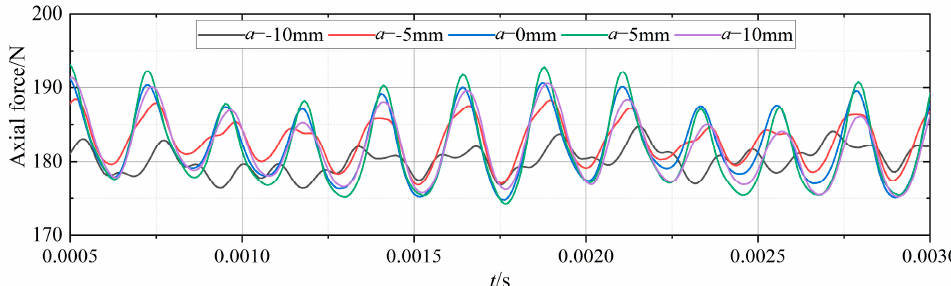
Figure 9. Axial force–time domain distribution under design conditions.